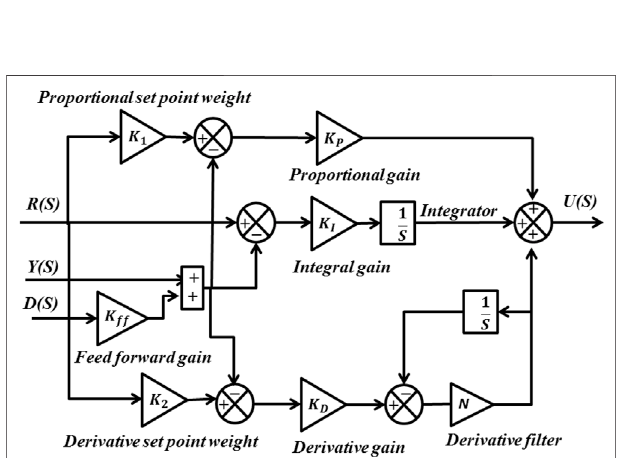
FIGURE 5 | Structure of the 3DOF-PID controller (Elsisi,